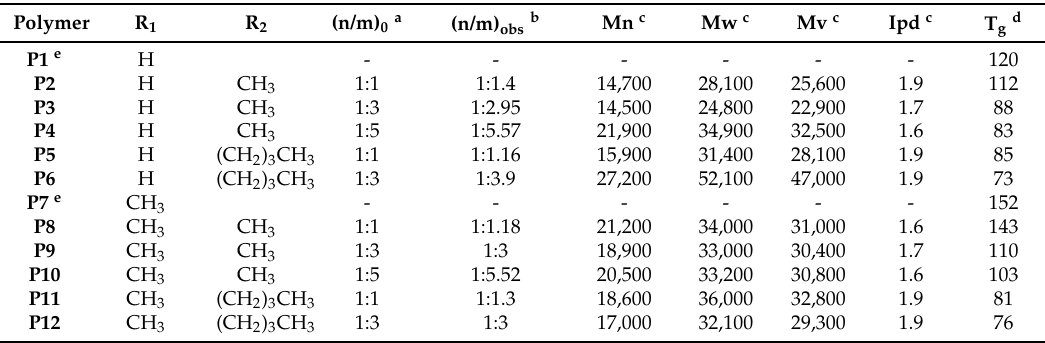
Table 1. Results of radical polymerization of 10% methacrylic monomers (case of monomers 3a and